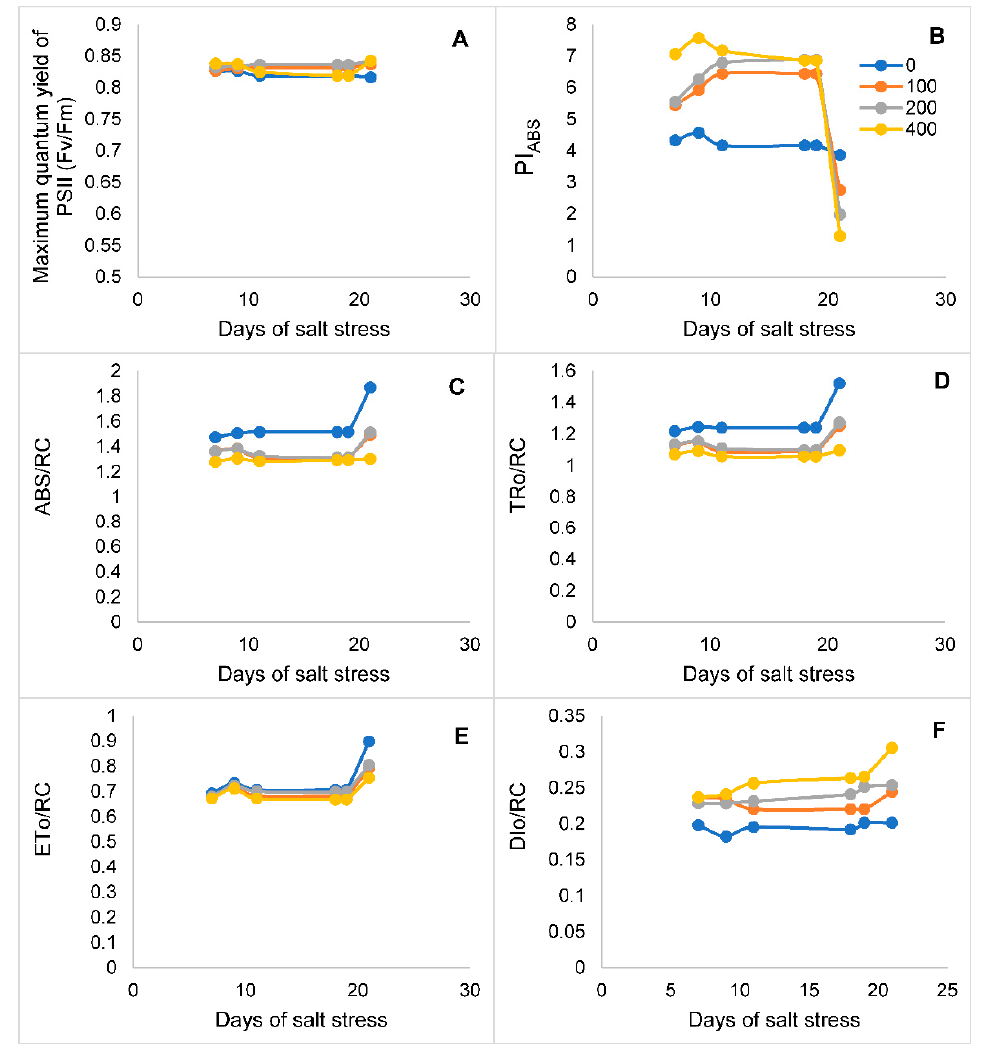
Figure 3. JIP-test parameters of canola cultivars when two-week-old plants of canola cultivar Oscar were subjected to salt stress (0, 100, 200, and 400 mM NaCl). ( A ) Maximum quantum yield of PSII. ( B ) Performance index (PI ABS ). ( C ) Absorption flux (ABS/RC). ( D ) Trapping flux (TRo/RC). ( E ) Electron transport flux (ETo/RC). ( F ) Heat dissipation flux